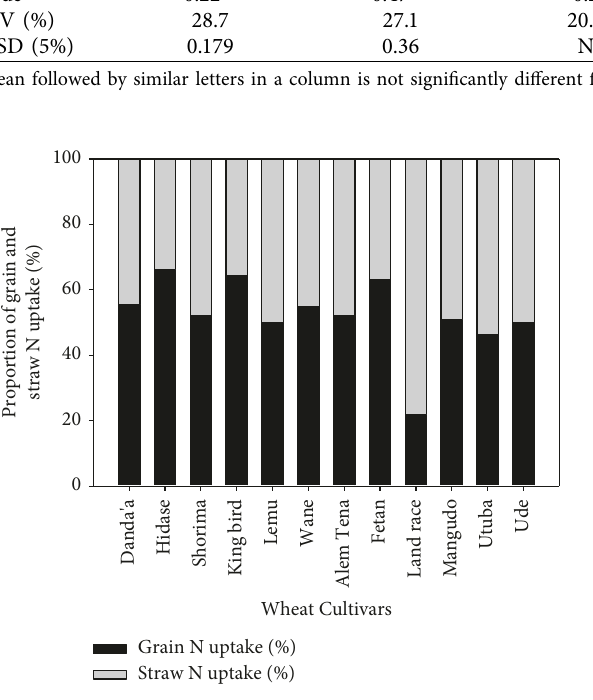
Figure 7: Relative proportion of grain and straw N uptake by wheat (Figure 2). In line with the current results, Kizilgeci et al. [38]